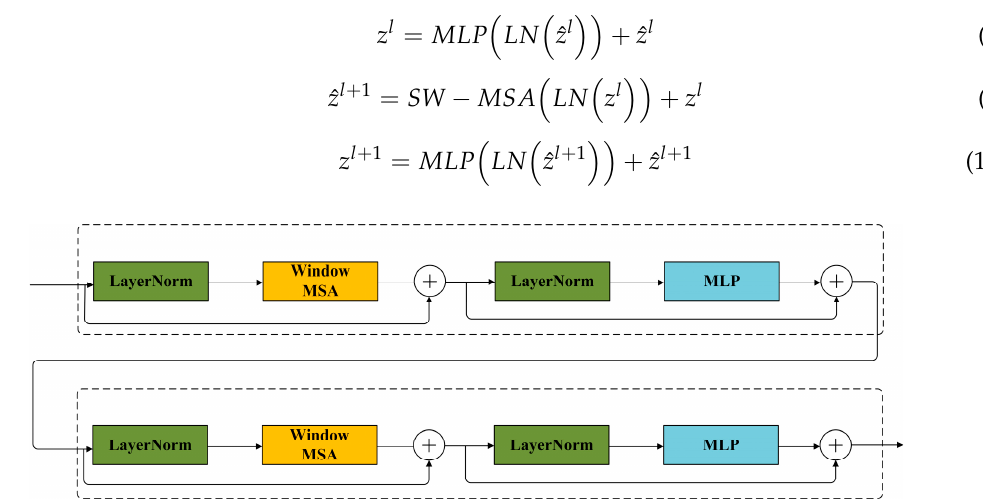
Figure 6. Swin transformer block.